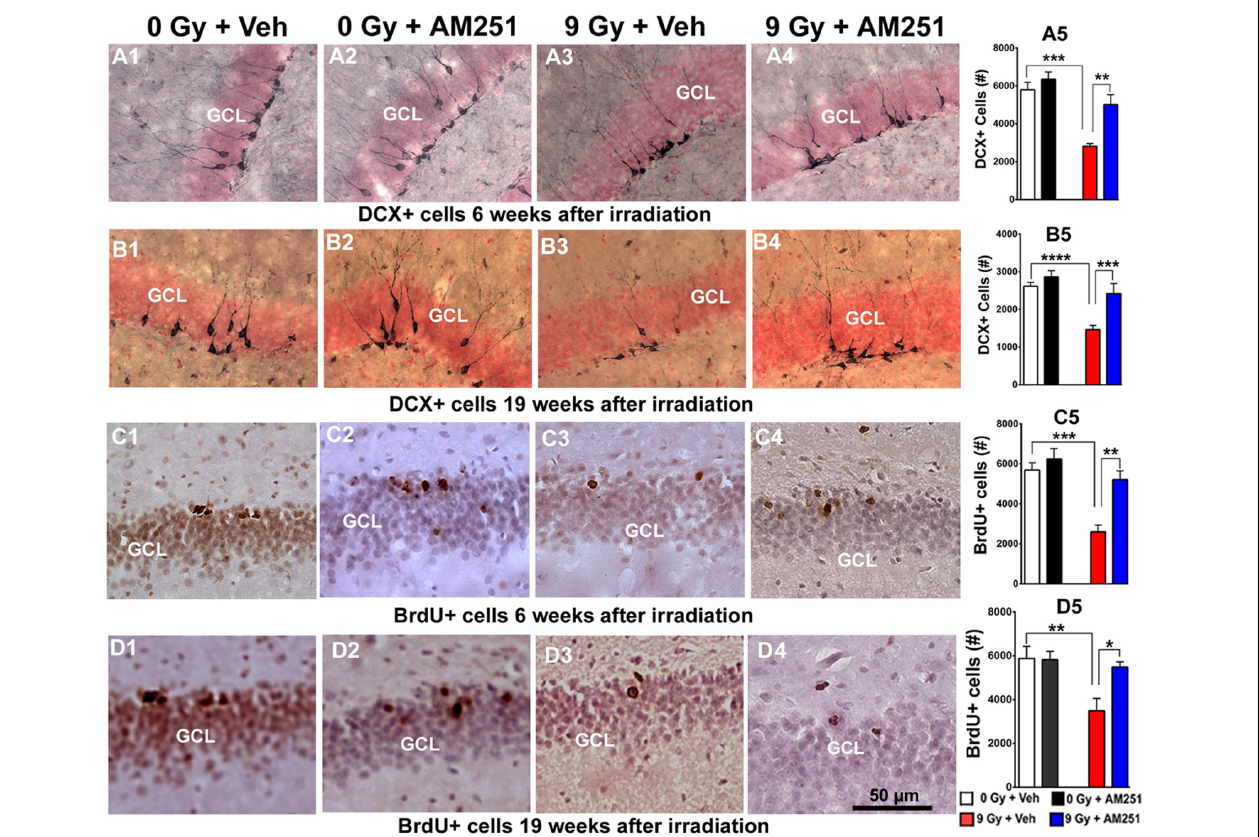
FIGURE 4 | AM251 preserves the number of immature neurons and cell proliferation in the irradiated hippocampus of mice. DCX: Representative images showing density of immature neurons (DCX + cells, brown staining) in the SGZ-GCL of the hippocampus (pink, nuclear staining) at 6 (A1–A4) and 19 weeks (B1–B4) following irradiation. At 6- and 19-weeks postirradiation, significant radiation-induced reductions in the number DCX + immature neurons were found, an effect that was ameliorated significantly by short- (A5) and long-term (B5) AM251 treatments, respectively. BrdU: Representative confocal images showing BrdU + cells (darkly staining) in the SGZ-GCL of the hippocampus at 6 (C1–C4) and 15 weeks (D1–D4) following irradiation. At 6 and 19 weeks postirradiation, significant radiation-induced reductions in the number of BrdU + cells were found which was prevented by short- (C5) and long-term (D5) AM251 treatments, respectively. Data presented as means ± SEM, N = 6. P -values derived from two-way ANOVA followed by Bonferroni correction for multiple comparisons. * P < 0.05; ** P < 0.01; *** P < 0.001; and **** P <